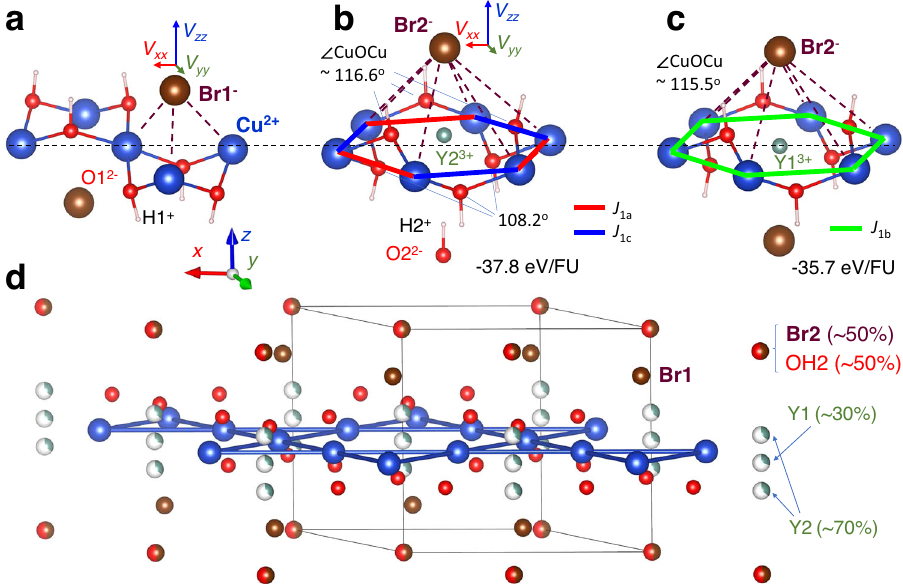
Fig. 1 Crystal structure of YCu 3 (OH) 6.5 Br 2.5 around the kagome layer of Cu 2 + . The Br1 nuclear ( 81 Br or 79 Br) spin detects three equidistant Cu 2 + electronic spins of each triangle on the kagome lattice ( a ), and the inset de fi nes the coordinate system for the spin components. Whereas, the Br2 nuclear spin mainly probes the nonsymmetric hexagon of spins with alternate exchanges ( b ), instead of the symmetric hexagon with almost uniform exchange ( c ). The formation energies of b and c stacking sequences are listed, and the different exchange paths of Cu-O-Cu ( J 1a , J 1b , and J 1c , depending on the bond angles) are marked. The principal axes of the electric fi eld gradient calculated by density functional theory at the Br1 ( a ) and Br2 ( b ) sites are displayed by arrows scaled by the modulus of the tensor element, V zz ~ − 2 V xx ~ − 2 V yy (Supplementary Note 6). In our measurements, the external magnetic fi eld is always applied along the z axis, and thus the second-order quadrupole shifts of the main NMR lines are negligibly small. d The crystal structure determined by the single-crystal x-ray diffraction 44 . The thin lines mark the unit cell.